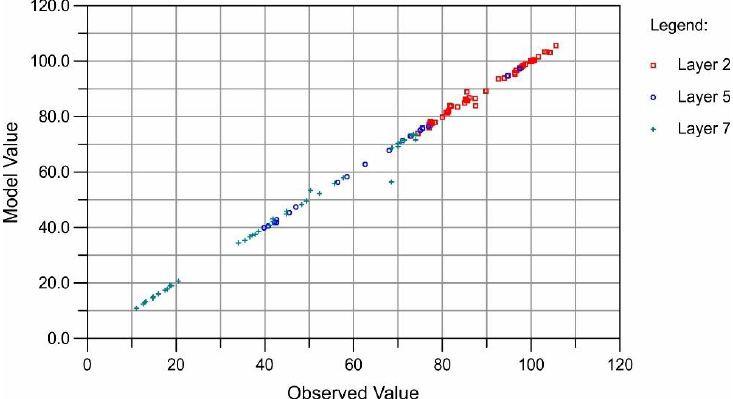
Figure 12. Calibration graph of recorded and modeled piezometric head (April 2014).